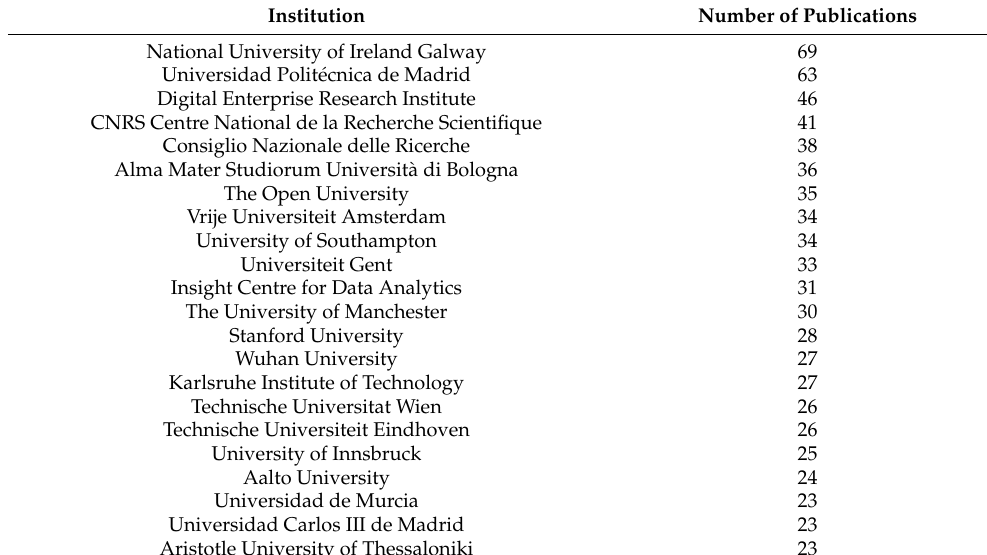
Table 4. Top 20 most productive institutions.